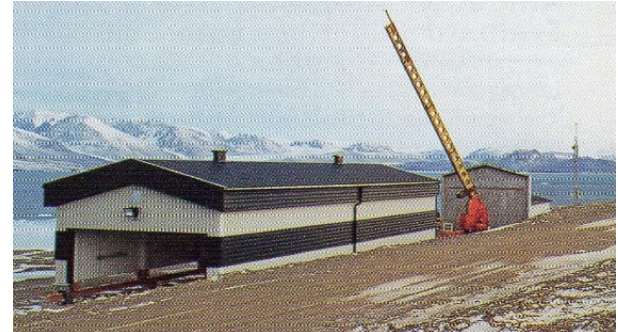
Figure 5. Total number of instrumented rockets launched (red columns) and number of payloads built in Norway (blue columns).